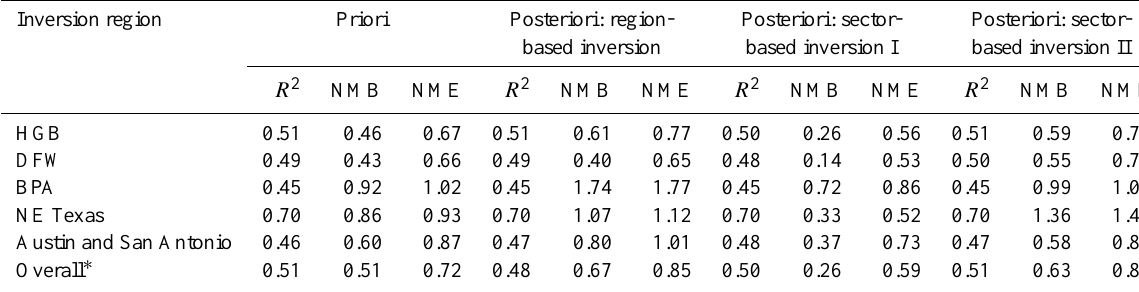
Table 4. Evaluation of CAMx-modeled NO 2 using hourly AQS ground-measured NO 2 . Inversion